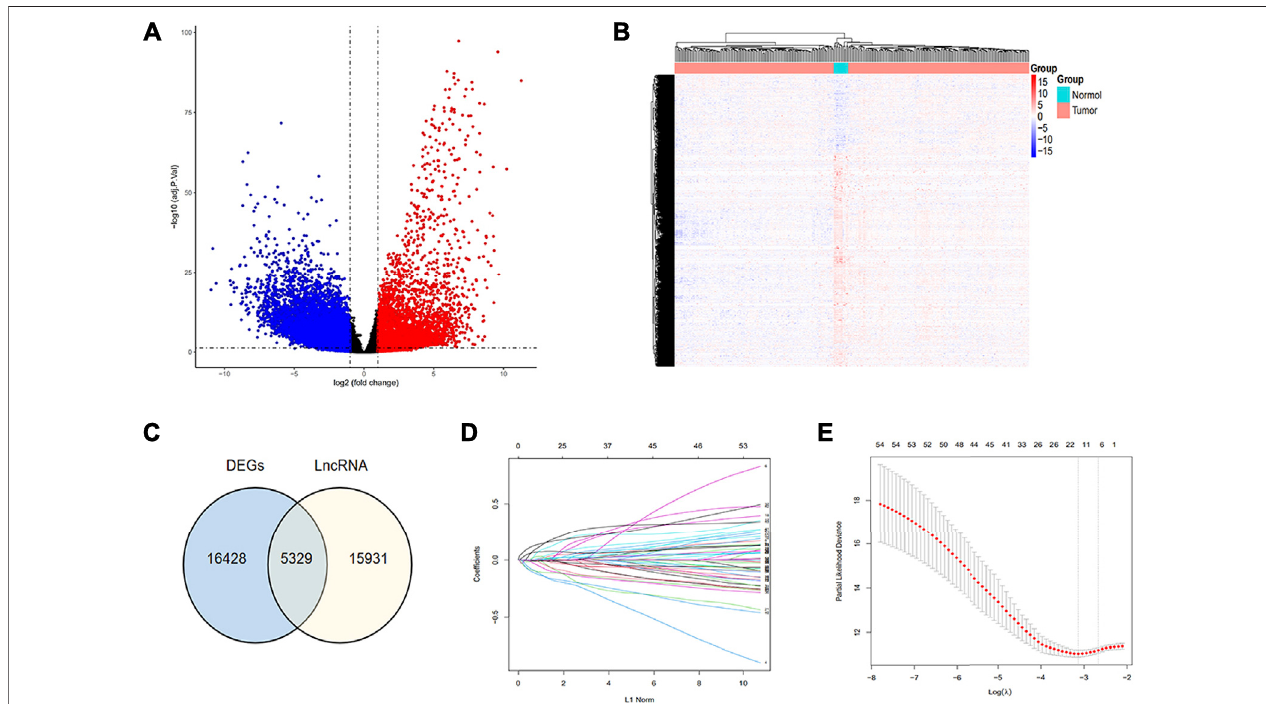
FIGURE1| RecognitionofhubimmunesignaturesinCC. (A,B) Volcanoplotandheatmapweredrawntoexhibitthedifferenceinexpressiongenesbetweentumor and normal samples; (C) Venn diagram was drawn to show the obtained DELncRNA signatures through intersecting lncRNA signatures with DEG; (D,E) Twelve hub immune-related lncRNAs were identi fi ed using the LASSO regression